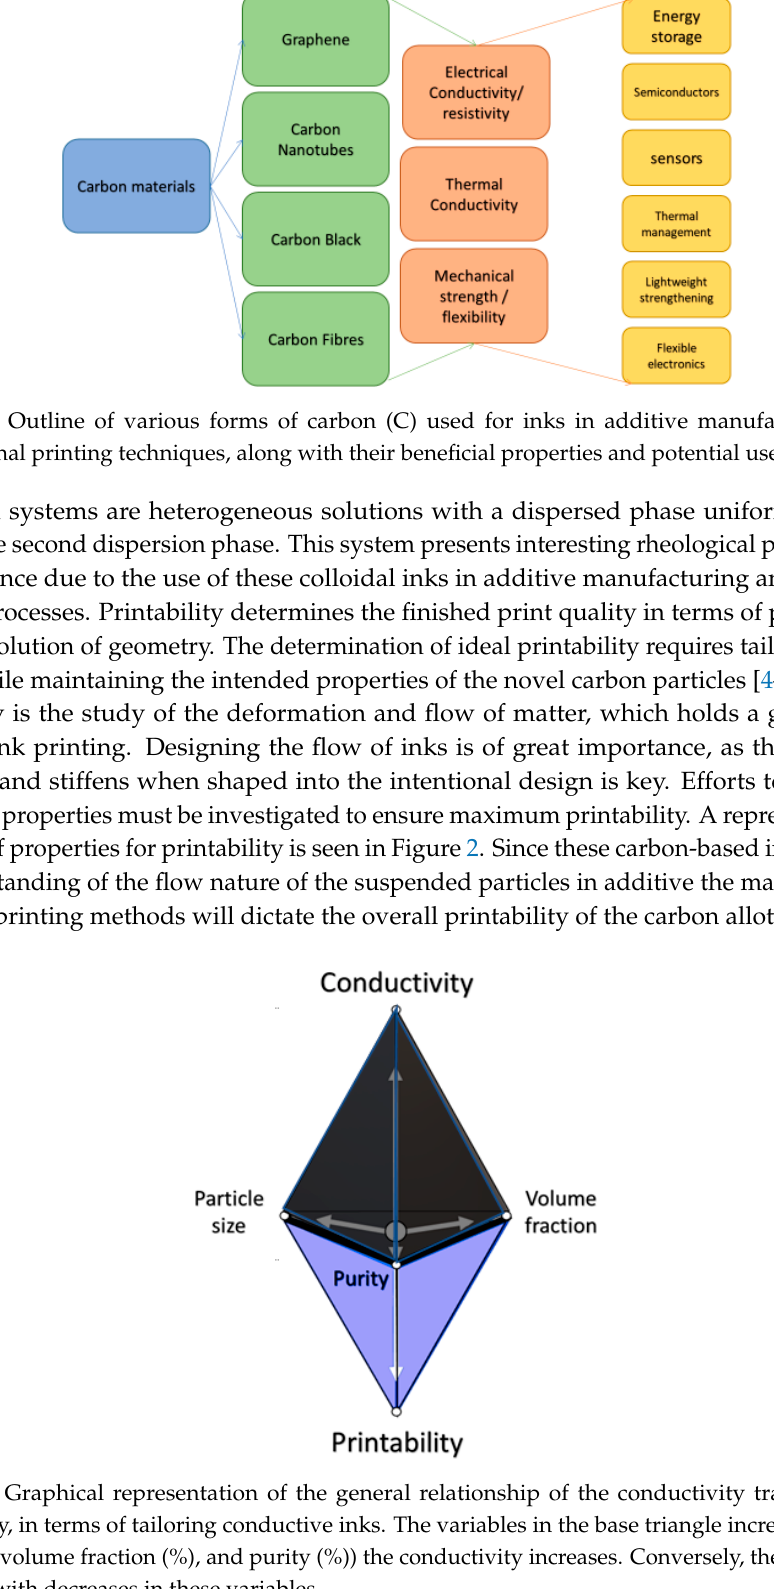
Figure 1. Outline of various forms of carbon (C) used for inks in additive manufacturing and conventional printing techniques, along with their beneficial properties and potential uses.